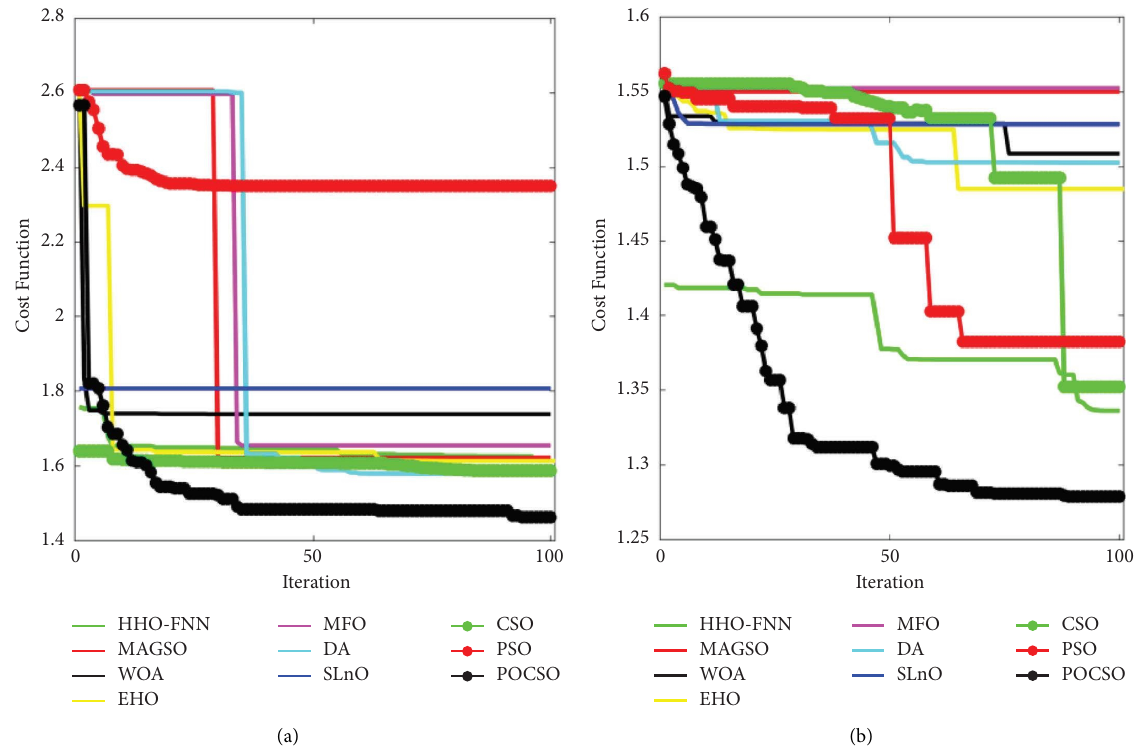
Figure 7: Convergence analysis of diverse optimization algorithm for (a) IEEE-14 bus system and (b) IEEE-30 bus system.